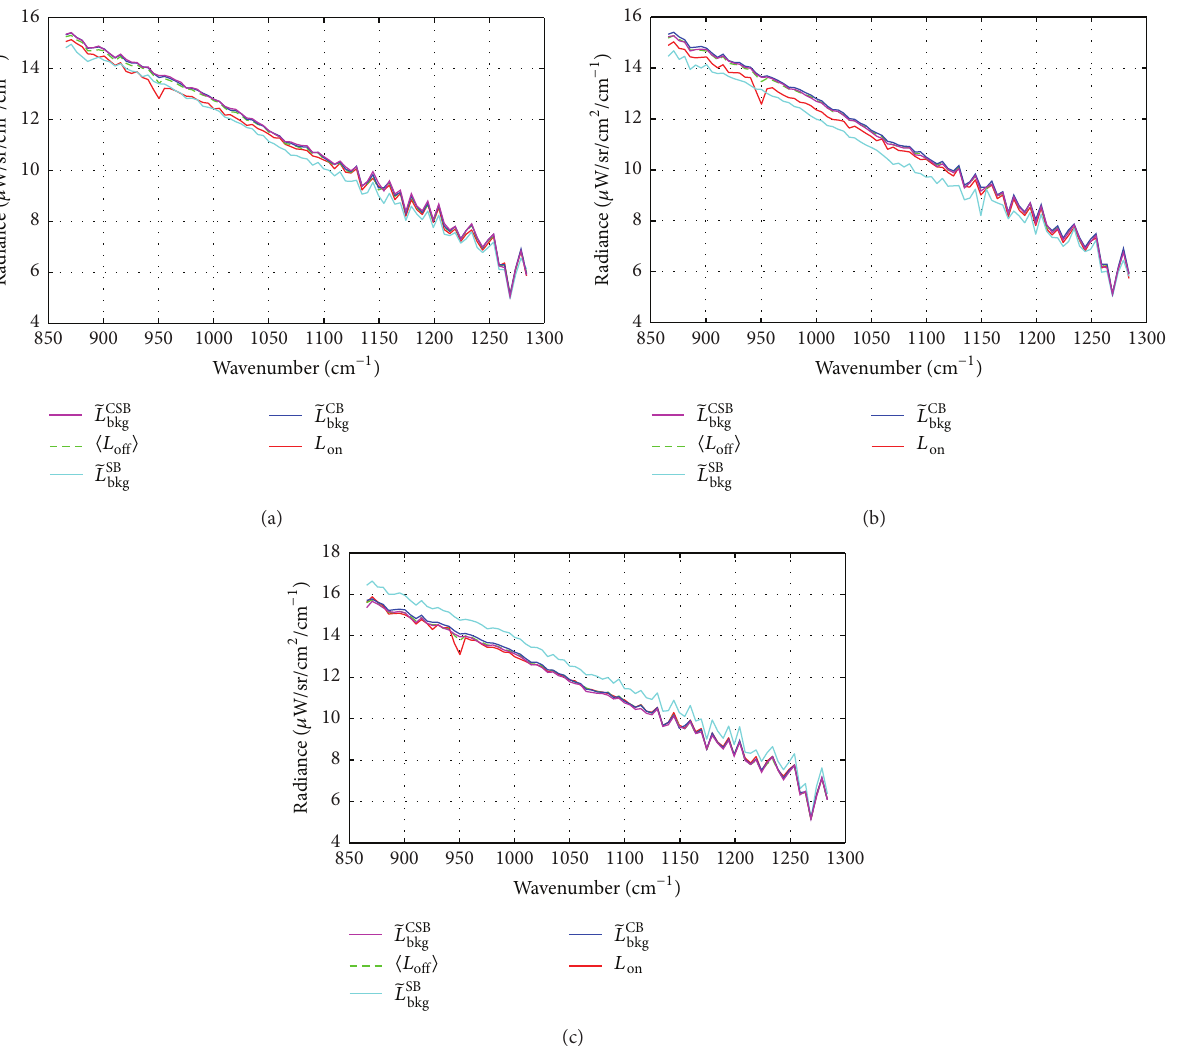
Figure 15: Comparison of background radiance estimation methods, for three different pixels through the plume. The red curves stand for the on-plumeradiances; thedotted green ones arethe expected background radiances. The cyan, blue, and magenta curves represent, respectively, the background radiance estimated by the SB, CB, and CSB methods. (a) Results for pixel 1, (b) results for pixel 2, and (c) results for pixel